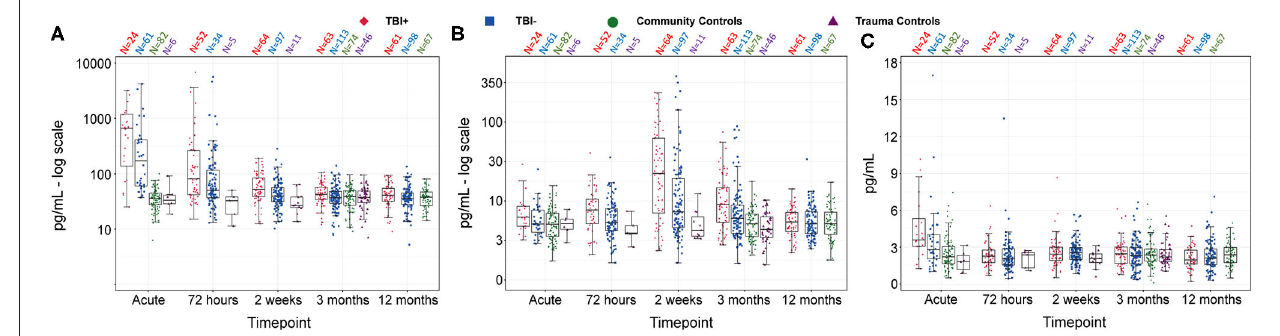
FIGURE 2 | Concentrations of GFAP (A) , NFL (B) , and tau (C) over time, for mTBI + , mTBI–, trauma controls and community controls. Data are presented as box plots with median as the midline, box borders representing the 25th and 75th percentile and whiskers calculated as the 25th and 75th percentile + 1.5 * interquartile range. Points above and below the whiskers represent outliers. Individual data points are presented within the box-plots. GFAP and NFL are presented on a log-transformed scale, while tau retains its original scale, for visualization purposes. GFAP, Glial fibrillary acidic protein; NFL, Neurofilament light; mTBI + , patients with mTBI and presence of other somatic injuries; mTBI–, patients with mTBI and no presence of other somatic injuries. N , number of participants in each group with blood at each timepoint.